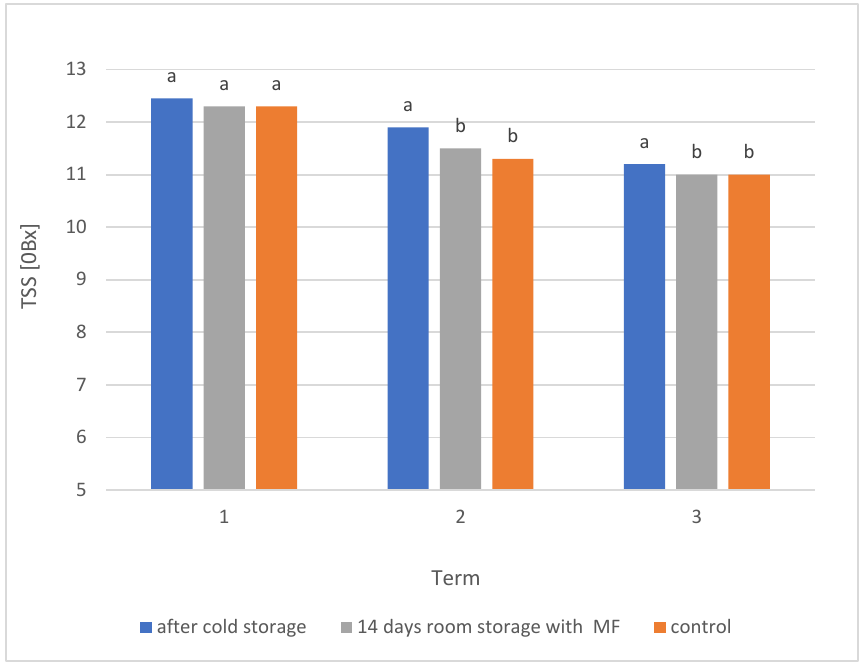
Figure 6. Effects of MF on the TSS of Ligol apples after 120 days of cold storage. For each experiment, apples were stored in room conditions for 14 days. Statistically significant differences are marked by different letters. Differences between average values that are marked with the same letters (a – b) are not statistically significant. The data were analysed separately for each experiment. The TSS of the stored apples varied significantly ( p < 0.05) in relation to temperature and duration of storage. The total soluble solid content of apples in cold storage (12.2%, on average) was higher than that of apples in room conditions with MF treatment (12.0%,